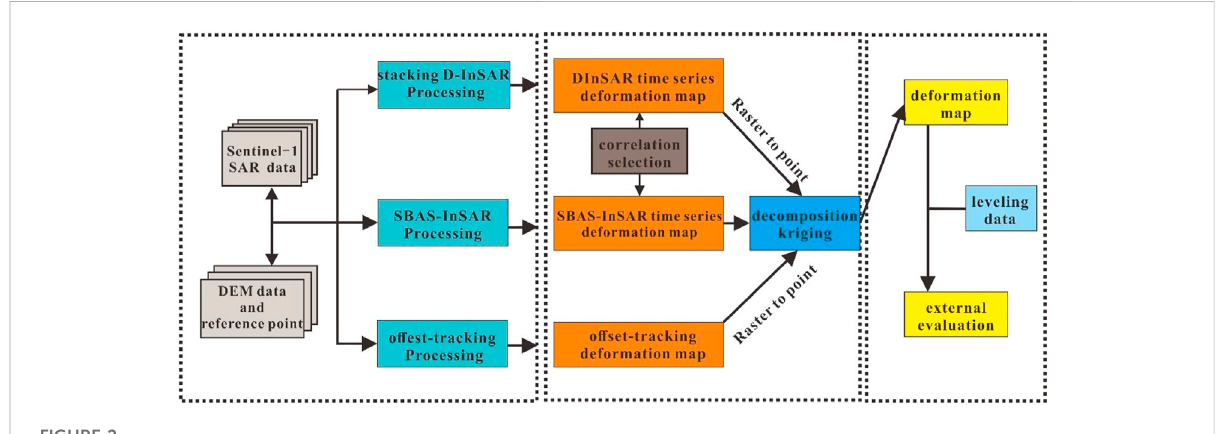
FIGURE 2 Schematic illustration of the Technology